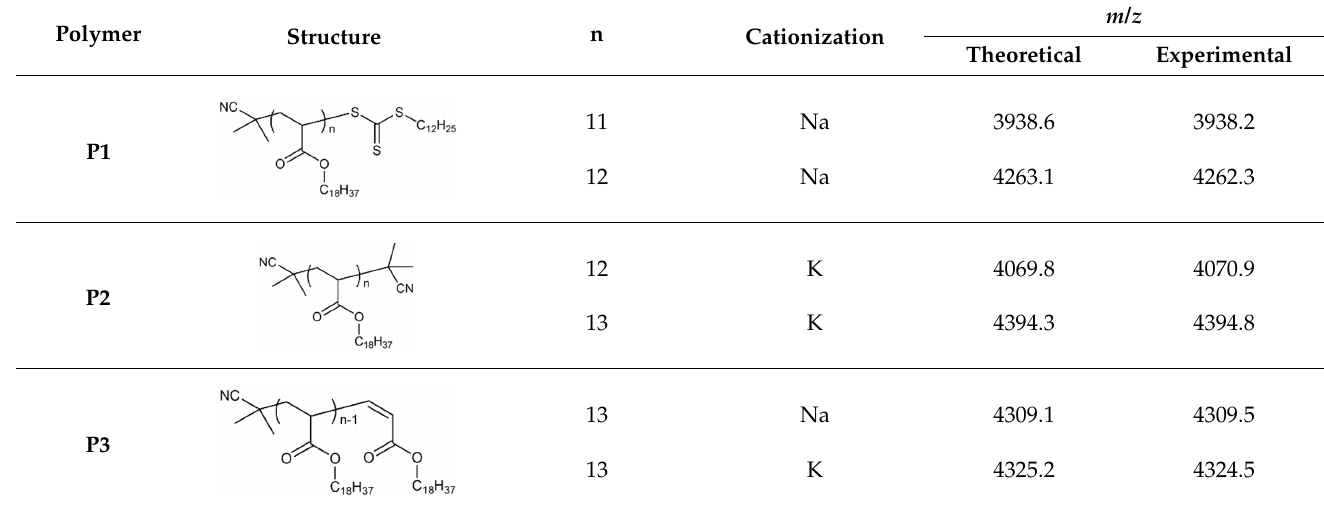
Table 5. Polymer structures corresponding to the peaks in Figure 4.